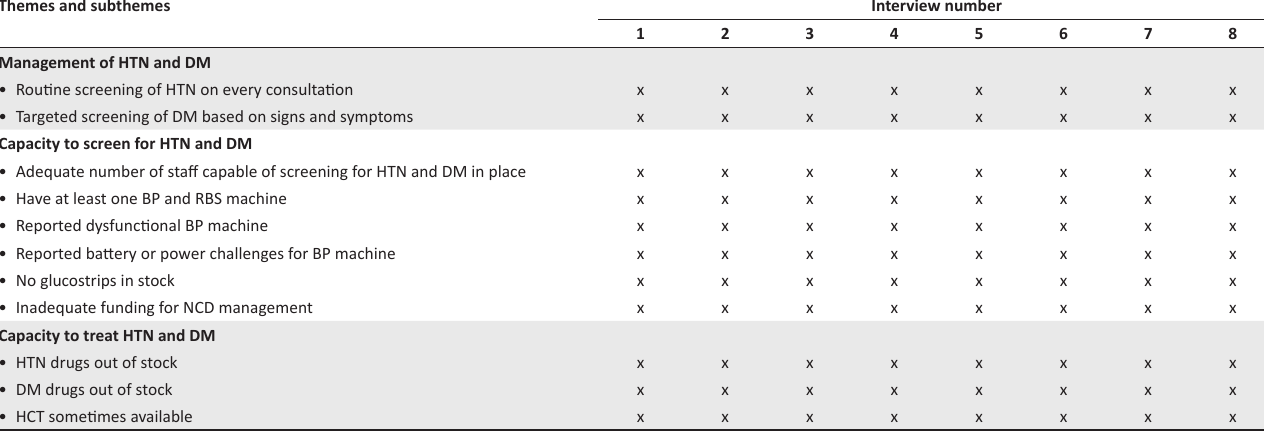
TABLE 2: Saturation grid of themes and subthemes emerging from key informant interviews. Themes and